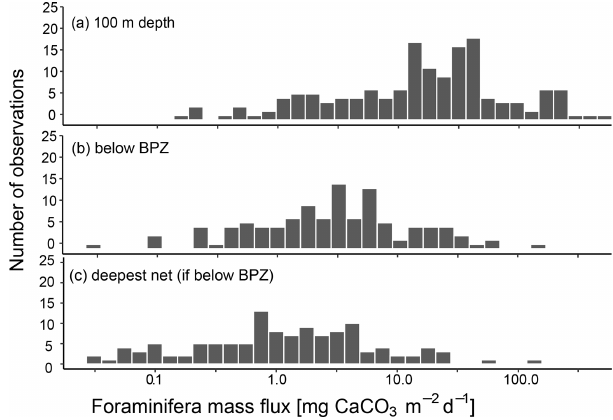
Figure 10. CaCO 3 mass flux of planktonic foraminifera N. pachy- derma , calculated based on shell weights of individual samples and, where no weight measurements are present, based on aver- age weights from the region or all samples included in this study. Consider the logarithmic scale of the x axis. Panel (a) shows the fluxes at around 100m depth (maximum sampling depths of nets: 75–100m), (b) the flux in the net below the calculated base of pro- ductive zone (BPZ) of the individual stations and (c) at the deepest net of each station including all stations where that is located below the BPZ. The exact width of sampling intervals differs between in- dividual sampling locations. Details on this are shown in Table 3 for profiles added in the study and in the references listed in Table